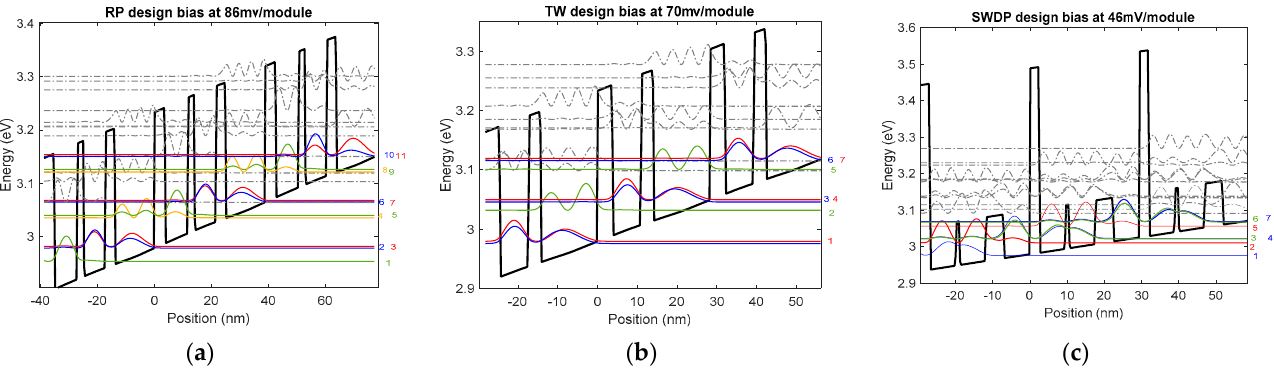
Figure 1. Band diagrams for the three THz_OCL designs: ( a ) RP, ( b ) TW, and ( c ) SWDP. In each diagram, three sequential periods are shown (Table 1 describes the designs and design parameters in more detail). Table 1. Main nominal design parameters and design data.